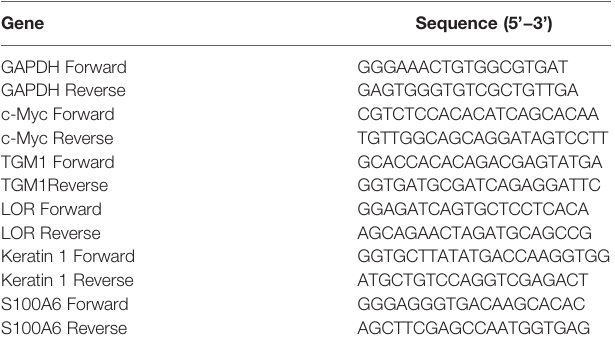
TABLE 1 | Primer sequences. Gene Sequence (5 ’ − 3 ’ ) GAPDH